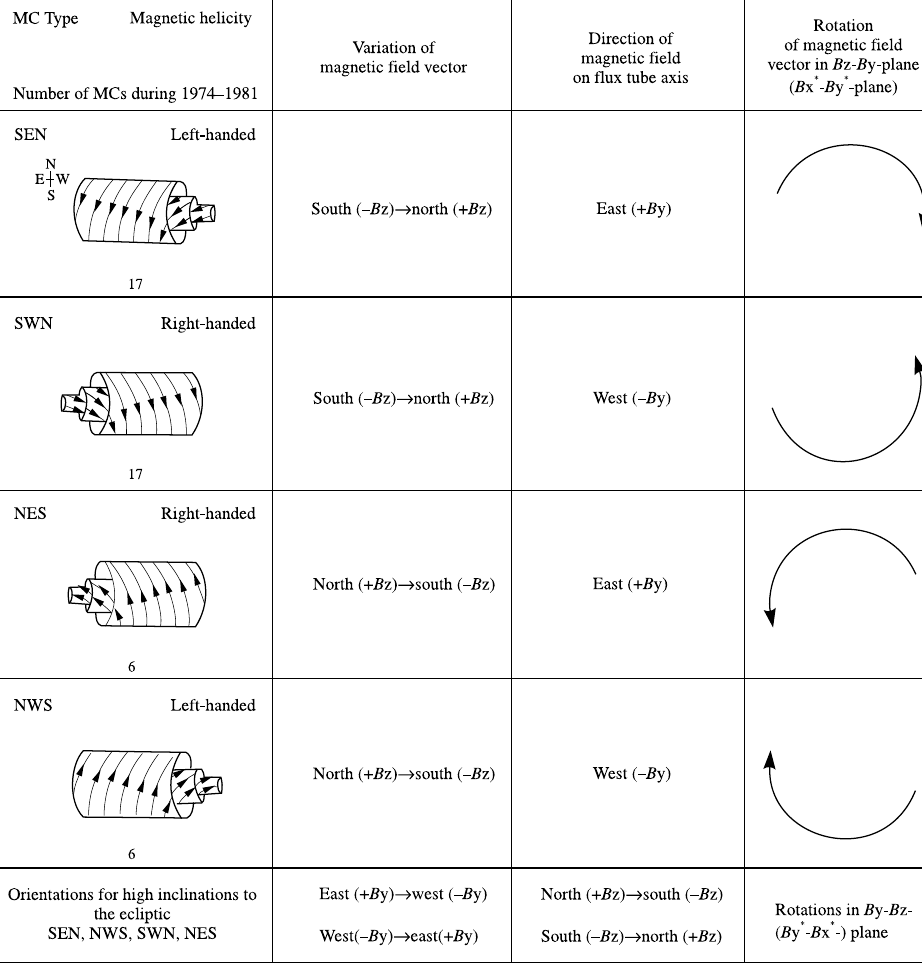
Table 2. Sketch showing the di(cid:128)erent magnetic configura- tions of MCs and their mag- netic helicity (left-handed (LH), right-handed (RH)) based on the magnetic flux- tube concept and the field rotation that a s/c would observe during the cloud’s passage. The number at the bottom indicates how often each MC-type was observed by Helios 1/2 between 0.3–1 AU